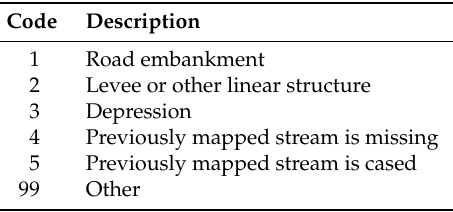
Table A2. Explanatory details for mapping units not connected in a natural way. Particularly code 4 and 5 in combination with the codes of Table A3 can also be used to indicate a change in connectivity (e.g., a change from direct towards diffuse connectivity).